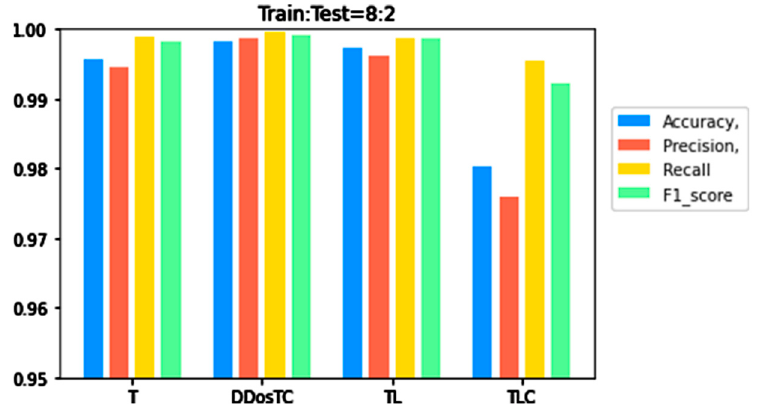
Figure 6. A performance comparison of DDosTC and transformer, tranformer + CNN + LSTM, and transformer + LSTM (Train/Test = 8:2).